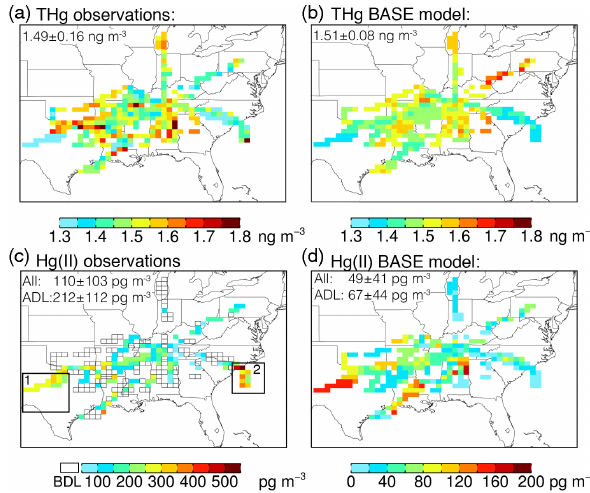
Figure 3. Horizontal distribution of THg (top panels) and Hg(II) (bottom panels). Observations are shown on panels (a, c) , while re- sults from the BASE GEOS-Chem simulation are on panels (b, d) . Observed and simulated values are averaged in 0.5 ◦ latitude by 0.625 ◦ longitude columns. For Hg(II) observations, the means in- clude ROS estimates for values below the detection limit (BDL). Locations where all observed Hg(II) concentrations were BDL are shown by open squares. Note the different color scales for the ob- served and modeled Hg(II) concentrations (c, d) . Regions marked as “1” and “2” highlight the areas with high Hg(II) and are refer- enced in the text and in Fig. 2. The numbers at the top of each panel indicate the means and standard deviations for all the modeled and observed concentrations. For Hg(II) we separate the statistics for all the measurements (“All”) and for the measurements above the detection limit